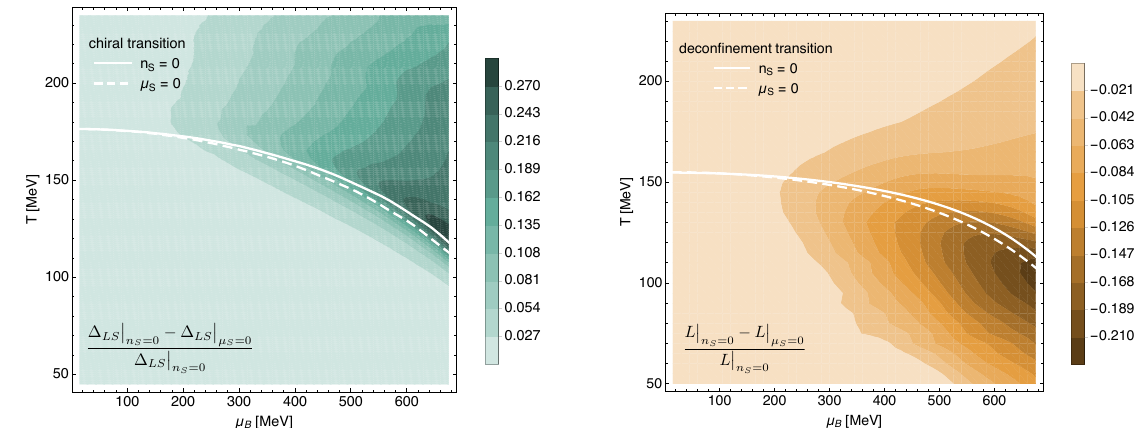
Figure 7: Left: Relative error of the subtracted condensate for strangeness neutrality = 0. The solid and dashed lines indicate the chiral phase boundary as defined and µ S ( T ) for n = 0 and µ = 0 respectively. Right: The same by the inflection point of ∆ LS S S for the Polyakov loop. Here, the solid and dashed lines indicate the deconfinement = 0 and µ = 0. phase boundary as defined by the inflection point of L ( T ) for n S S The result is given by the density profile in the left plot of Fig. 7. The darker the color, the